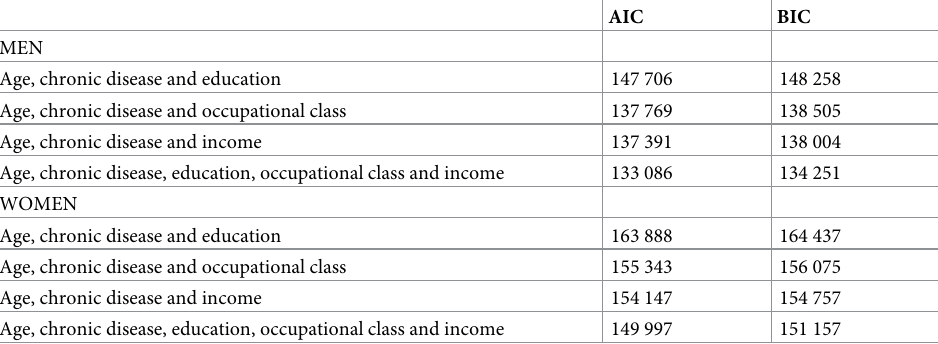
Table 3. Akaike’s information criterion (AIC) and Bayesian information criterion (BIC) values for different sets of models including the socioeconomic